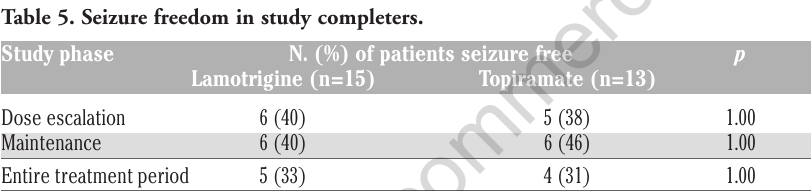
Table 5. Seizure freedom in study completers.